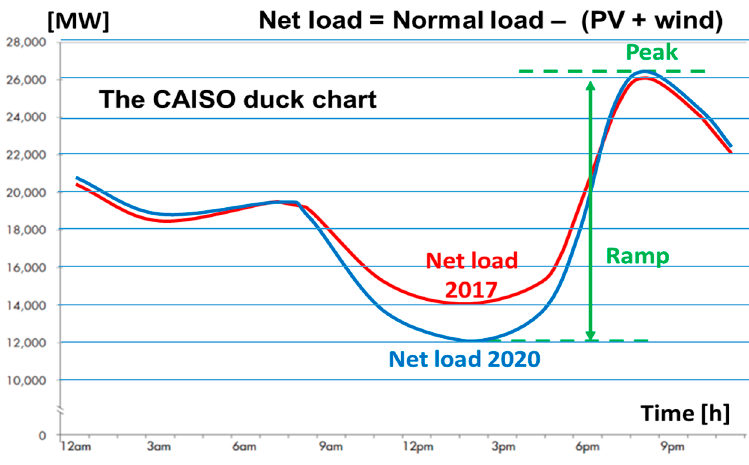
Figure 1. Californian duck curve, specific to high solar penetration. Simplified view from [3].